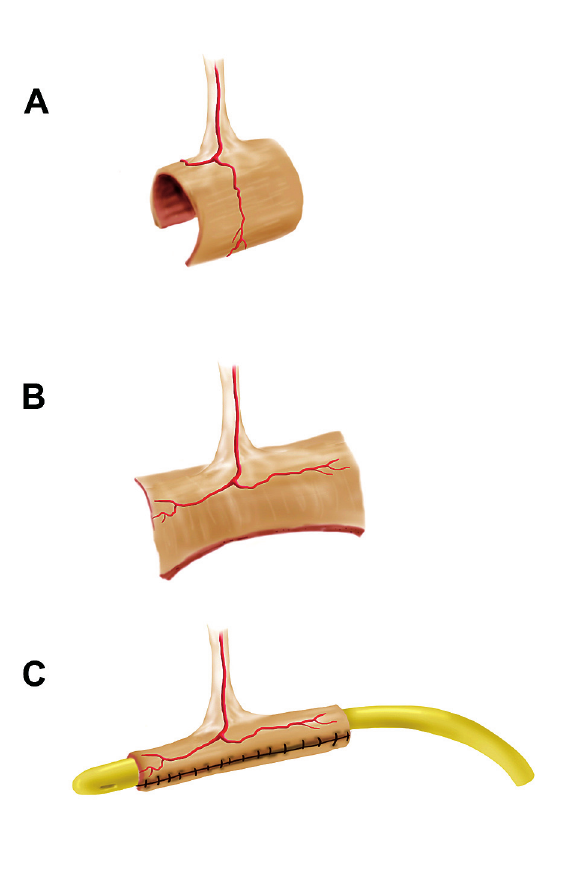
Figure 1 – Isolating a 2 to 2.5 cm segment of ileum (A) and opening it from its anti-mesenteric border (B) and finally retu- bularization along its longitudinal axis